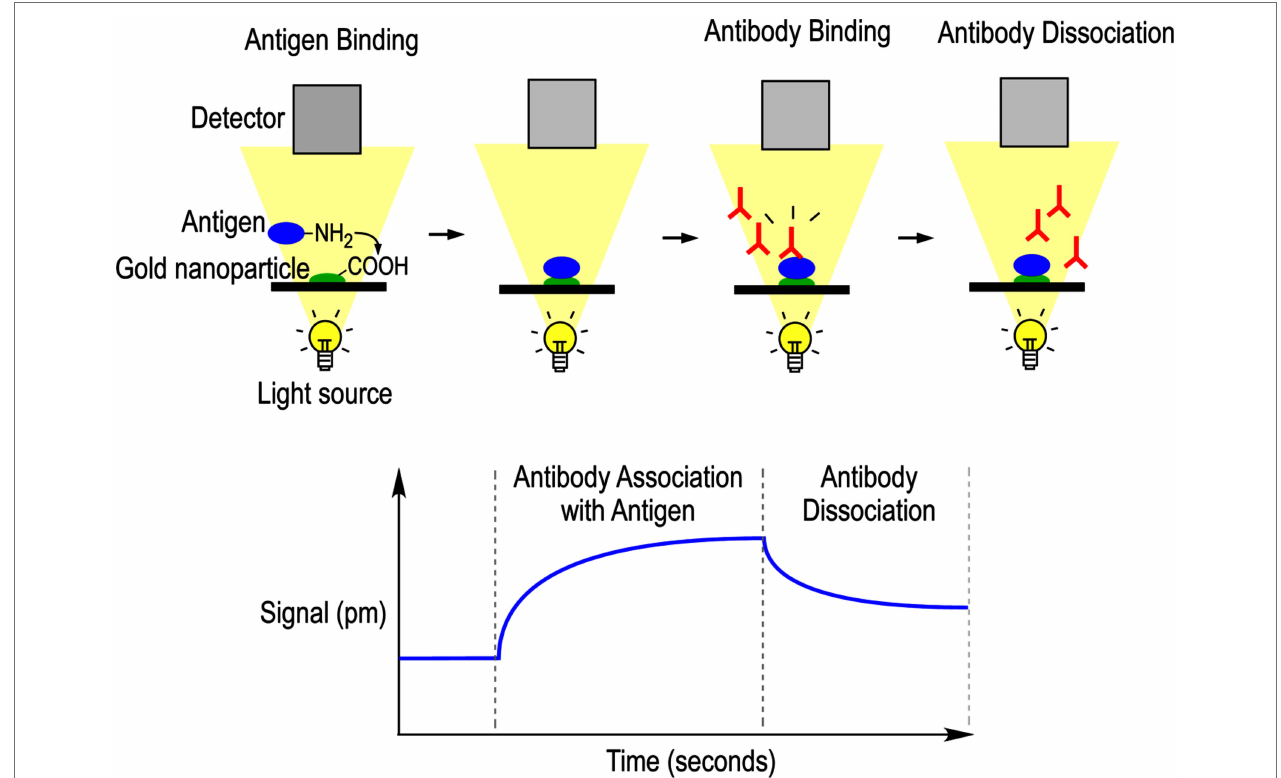
FIGURE 3 | Localized surface plasmon resonance-based mAb epitope analysis. Protein of interest was attached to a carboxy-functionalized gold nanoparticle via covalent bonding with lysine residues. The protein was permitted to equilibrate in running buffer, and then the mAb probe diluted in the same buffer was permitted to flow over the chip and interacts with the protein. Interactions were measured via local changes in refractive index that are reflected in optical signal detection. Running buffer was then flushed over the chip to promote mAb dissociation. The resulting signal measured by the optical detector is plotted against time to calculate antibody association and dissociation rate